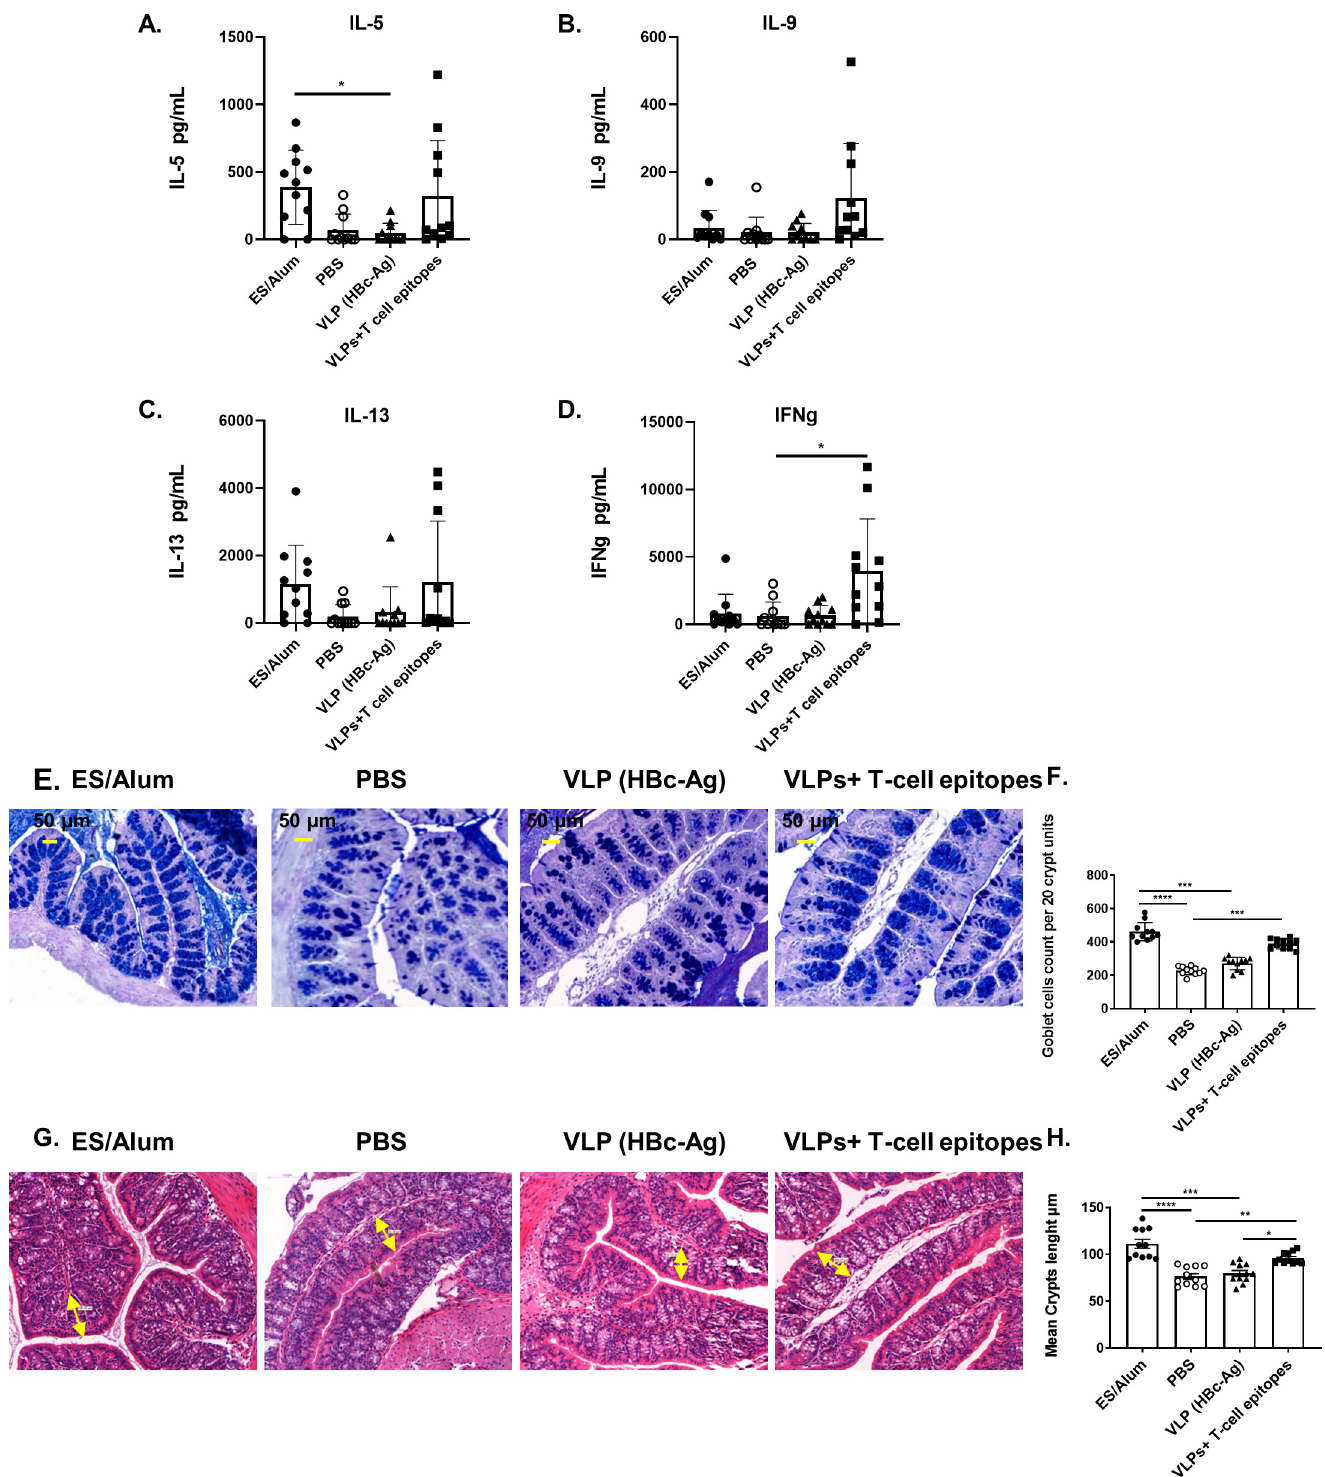
Fig 4. Cytokine productions by mesenteric lymph node cells, quantification of goblet cell numbers and changes in intestinal pathology in T . muris infected mice vaccinated with VLPs+T-cell epitopes and control mice. (A) MLNs from mice vaccinated with 50 μ g of pre-mixed of VLPs+T-cell epitopes (HBc-CBD 1243- 1259 , HBc-CBD 241-257 , HBc-CLSP 143-158 and HBc-CLSP 398-416 ), 50 μ g of VLP (HBc-Ag), 50 μ g ES/Alum, or PBS on day -20 and boosted on day -10 were stimulated at 5x10 6 /ml with 50 μ g/ml T . muris ES. After 48 hours of stimulation, cell culture supernatants were harvested and assayed by cytometric bead array for IL-5 (A), IL-9